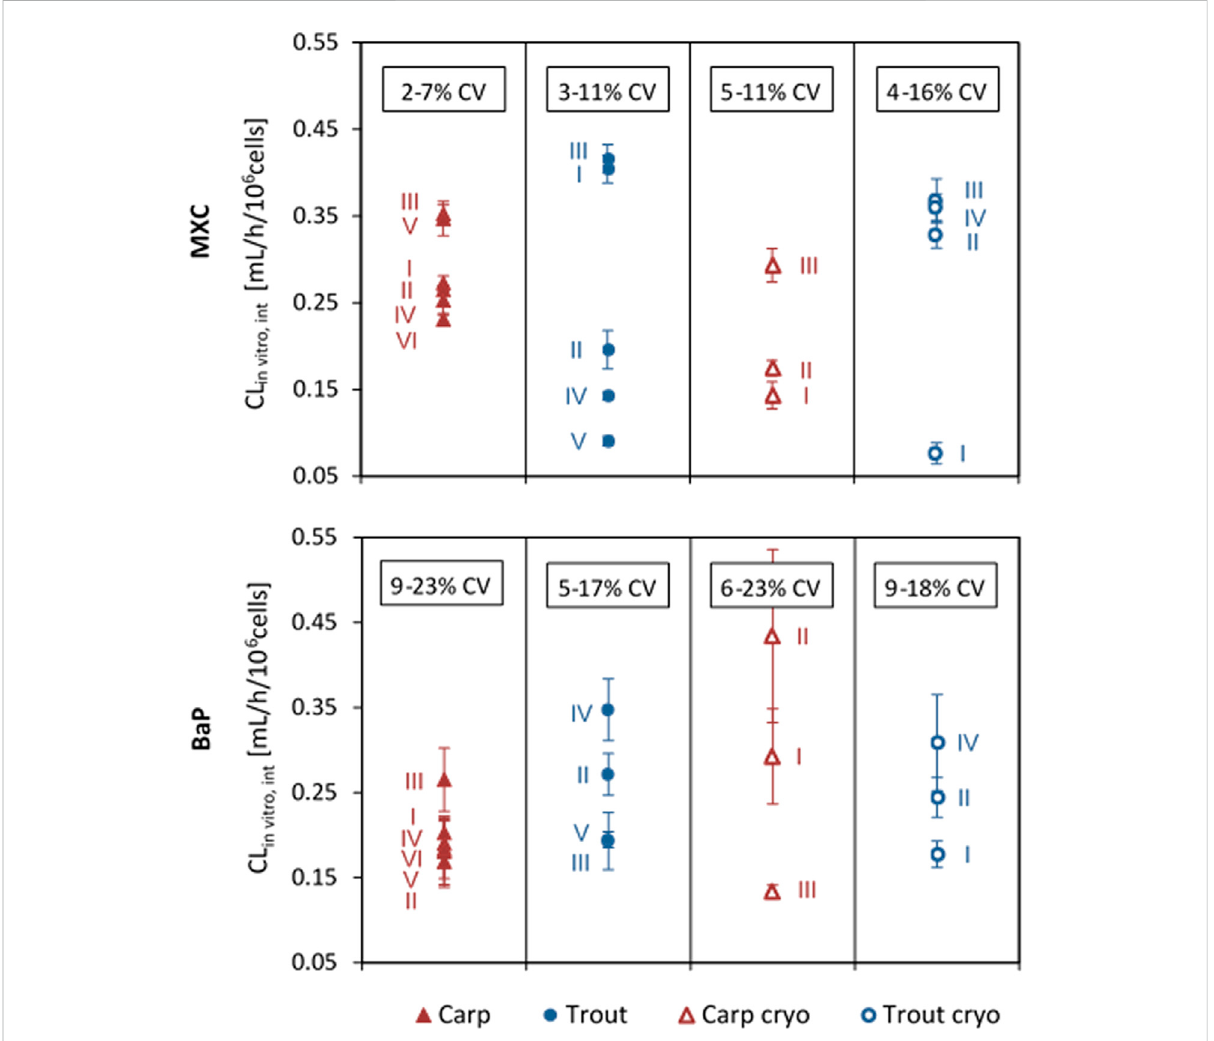
FIGURE 2 In vitro intrinsic clearance (CL in vitro, int ) of methoxychlor (MXC) and benzo[a]pyrene (BaP) in common carp and rainbow trout hepatocytes. Values are normalized to 10 6 cells, using the nominal test concentration of 2 × 10 6 cells/mL. Values represent the average CL in vitro, int from technical triplicates for each run. Error bars indicate the standard deviation (SD) between triplicates. The range of total coef fi cient of variation (%CV) values obtained for the triplicates in the different groups is provided in the